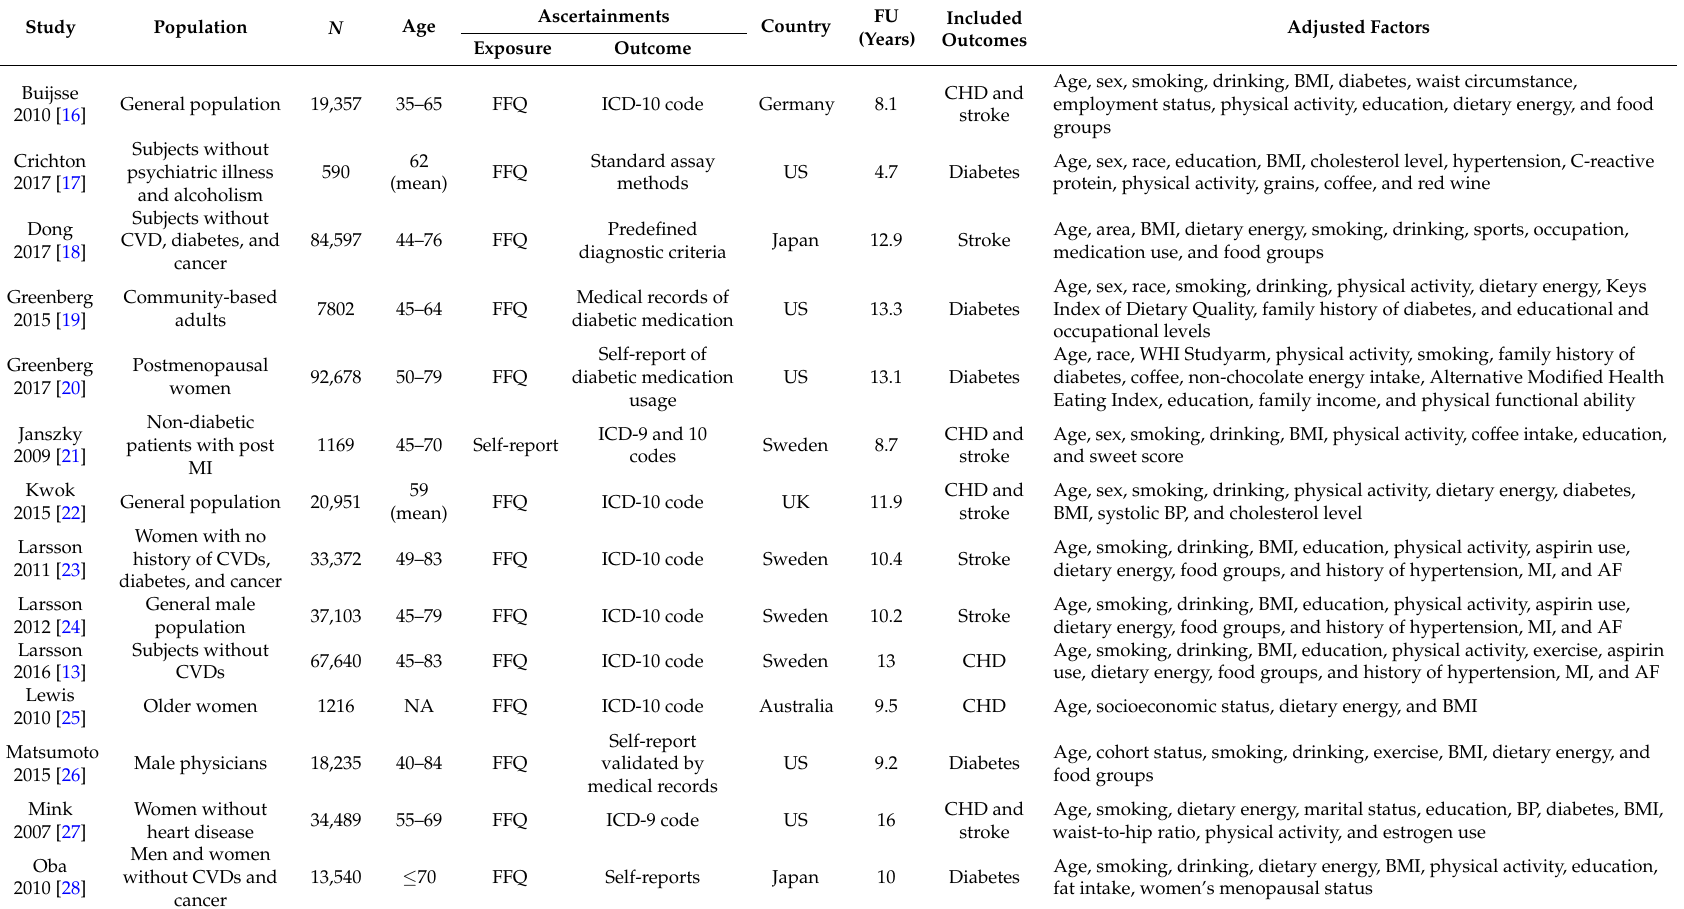
Table 1. Baseline characteristics of included